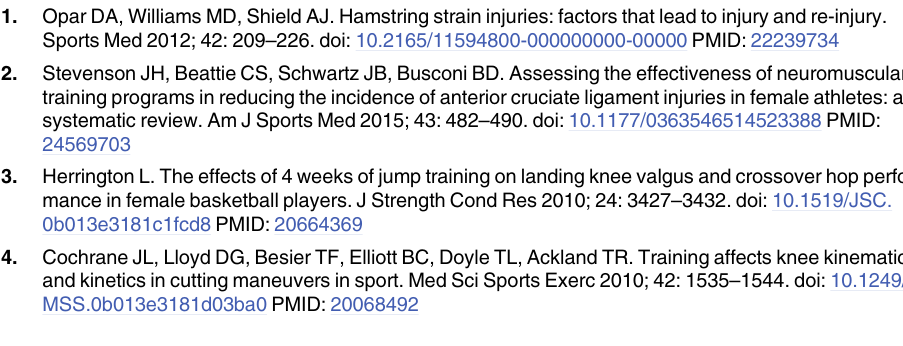
S2 Table. Supporting information including the 56 excluded studies and reasons for exclu-